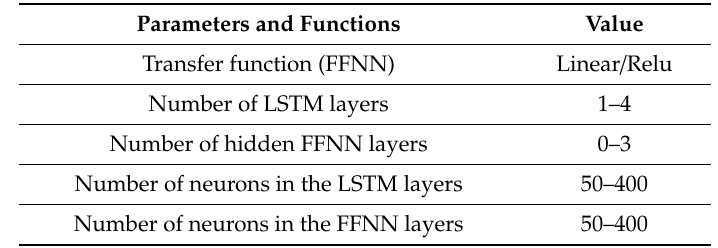
Table 4. Parameters and functions associated with DL forecast model. FFNN stands for feedforward neural network. LSTM for long short-term memory.